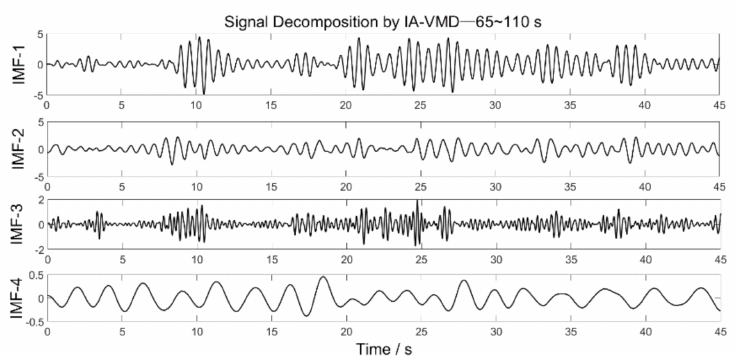
Figure 9. IMFs extracted from the ambient